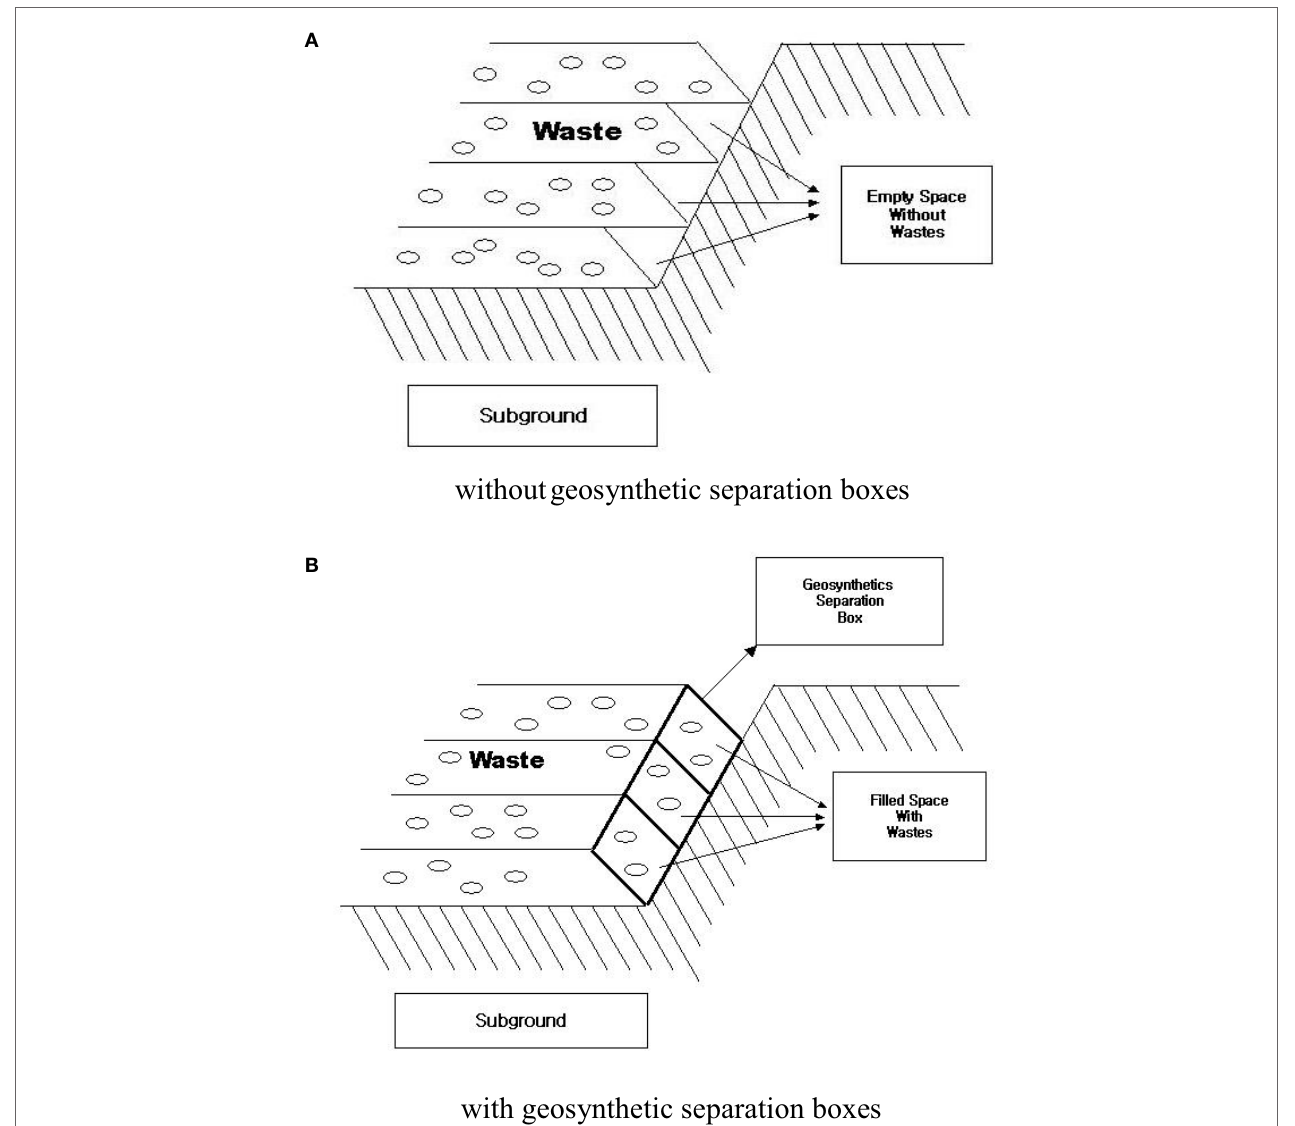
FigUre 1 | schematic diagram of waste landfills with and without geosynthetic separation boxes . (a) Without geosynthetic separation boxes. (B) With geosynthetic separation